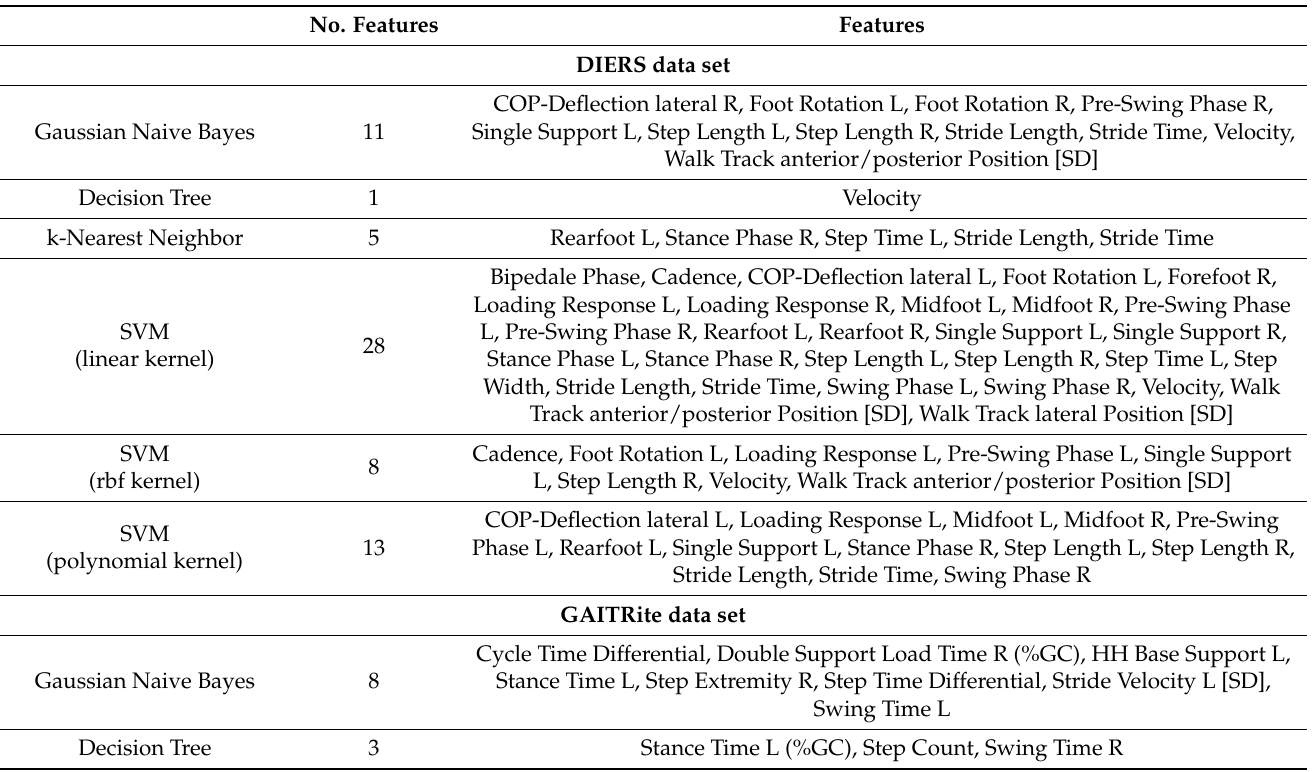
Table A2. List of all top-n-relevant features for each individual data set (matched collective) and classification model. The parameters have been recorded and merged for the left and right sides (L/R). The gait parameters are given in their mean value. If the standard deviation of the gait parameter is meant, it is explicitly followed by [SD]; SVM = Support Vector Machine; rbf = radial basis